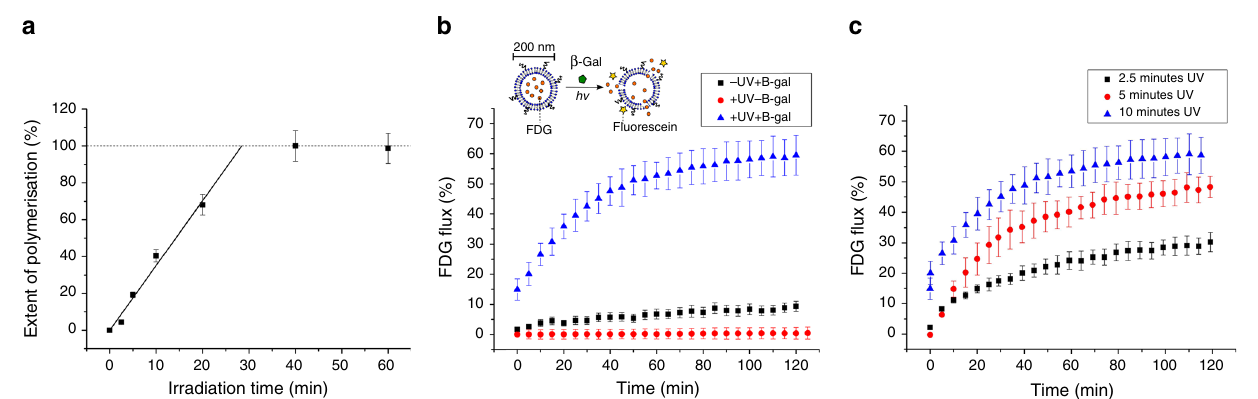
Fig. 2 DC 89 PC polymerisation can trigger substrate release. a Extent of DC 89 PC polymerisation correlates with UV irradiation time. Extent of polymerisation estimated through normalisation of changes in absorbance at 475 nm, and applying a linear fi t to estimate polymerisation saturation ( r = 0.998). b UV-C irradiation can be used to ef fi ciently and quickly release FDG from vesicles containing DC 89 PC. Vesicles irradiated for 10 min, with/without the presence of 5 Uml − 1 β -galactosidase. c FDG release can be modulated by changing irradiation time. β -galactosidase enzyme is present at 5 Uml − 1 in each case. Error bars represent 1 s.d. ( n = 3) for each